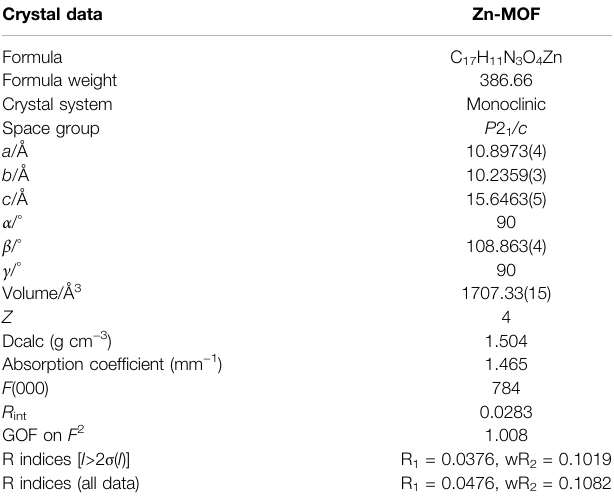
TABLE 1 | Crystallographic data for Zn-MOF complexes. Crystal